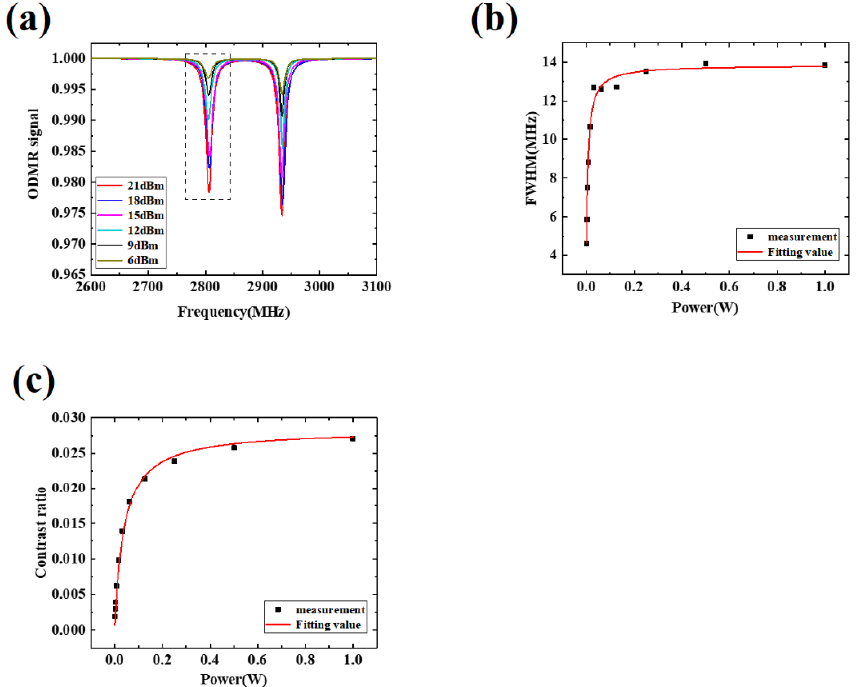
Figure 3. ( a ) ODMR signal with different microwave power; ( b ) Relationship between FWHM and microwave power at pixel 1; ( c ) Relationship between contrast and microwave power at pixel 1.